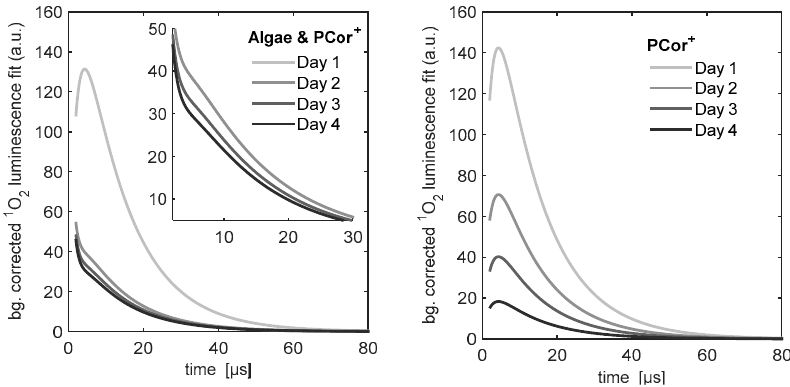
Figure 5. Temporal development of the singlet oxygen signals, measured on the surfaces of the PCor + reference samples and the samples of PCor + incubated in green algae over four days.